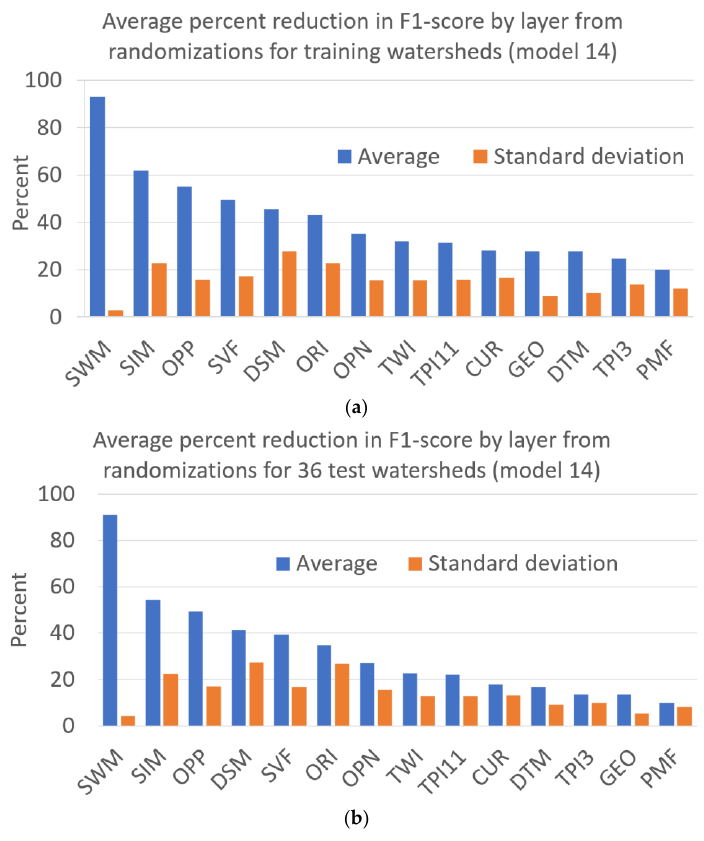
Figure 16. Average percent reduction in F1-score of each input layer for U-net model 14 that uses 14 watersheds for training. Percent reduction for a layer is estimated from the average change in F1-scores from the original model determined from 10 models that separately randomize the layer 10 times. Average F1-score reductions for input layers in (a) the 14 training watersheds, and (b) the 36 test watersheds.